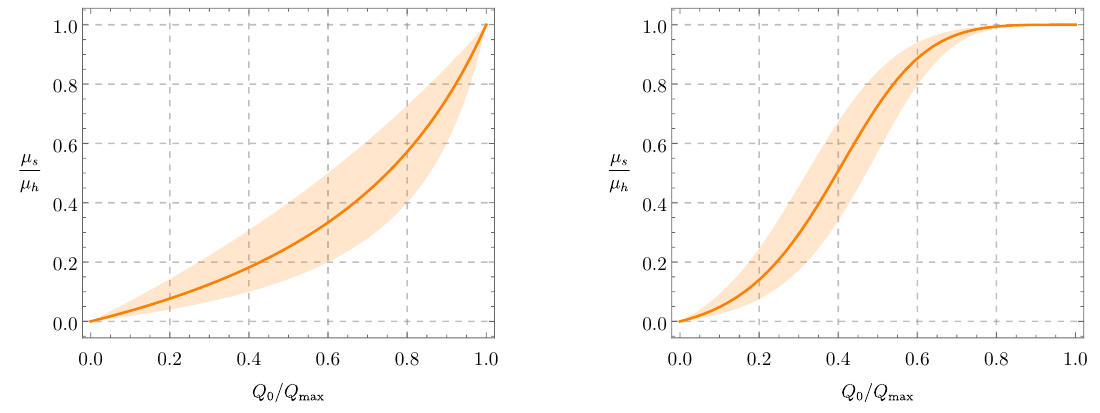
Figure 6 . The pro(cid:12)le function (4.3) for n = 1 (left plot) and n = 4 (right plot). We will use the n = 4 function as our default